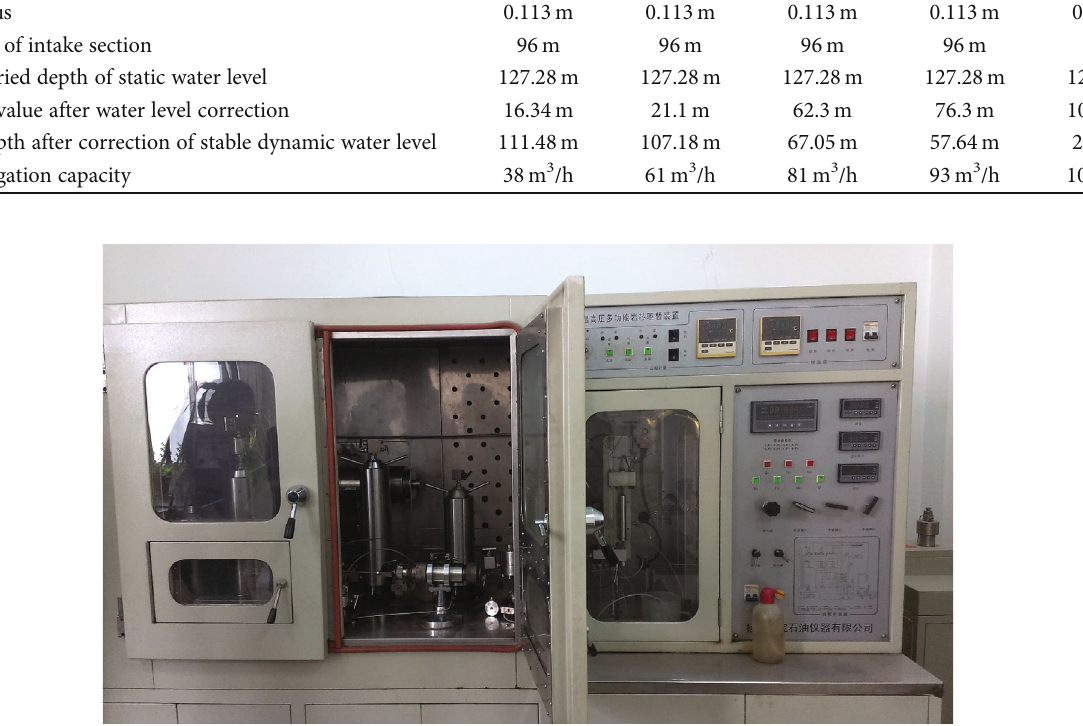
Figure 1: Experimental apparatus used in the